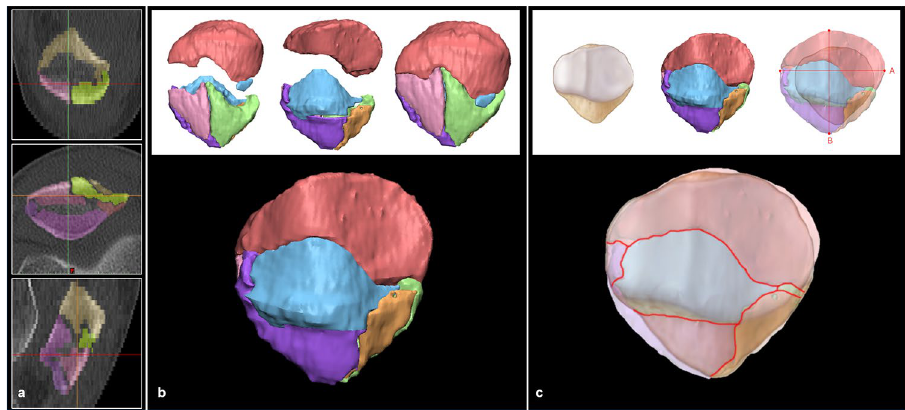
Figure 1. The software employing the method of mapping three-dimensional reassembled fracture models was used for coronal articular surface fracture mapping ( a ). Segmented fracture fragments were reassembled ( b ). Fracture lines that were present on the articular surface (red lines) were drawn on a standard template by superimposing captured images ( c